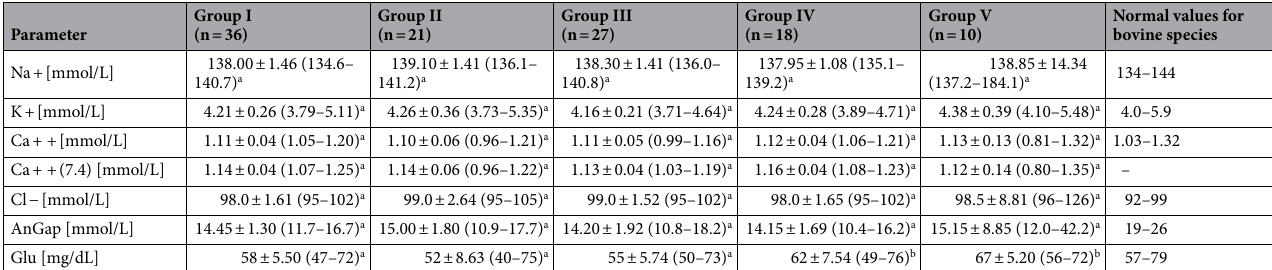
Table 4. Blood ion concentration (median, SD, minimal, and maximal values) in different groups of dairy cattle compared with the normal values for cattle (according to Sayers et al. 2016 30 , Wood et al. 2010 40 , Temiz et al. 2014 37 , and Cornell Animal Health Diagnostic Center 42 ). The cows were divided in to five groups: I—44 kg milk/cow; II—38 kg milk/cow; III—30 kg milk/cow; IV—25 kg milk/cow; and V—19 kg milk/ cow, based on mean daily milk yield. Means with different letters (a–b) are different ( P < 0.05). a– b means with different letters are different ( P < 0.05). AnGap Anion gap, Glu Glucose